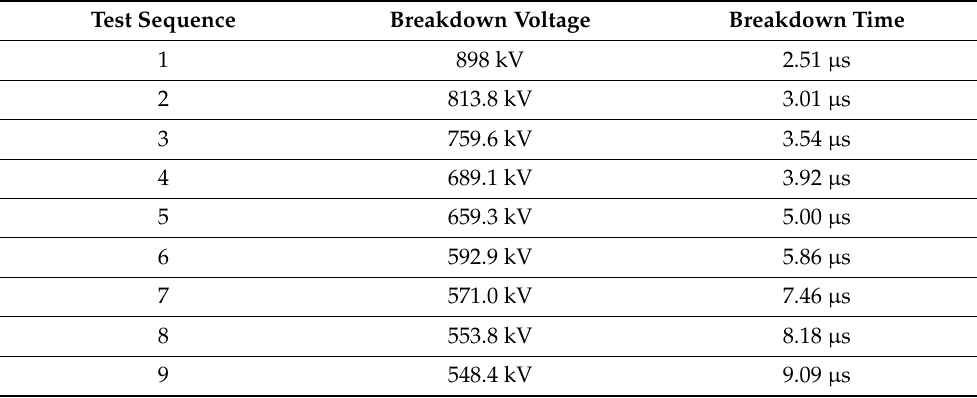
Table 3. Data of the volt-second characteristics test ( T = 29.9 ◦ C, P = 95.6 kPa, RH = 46%).